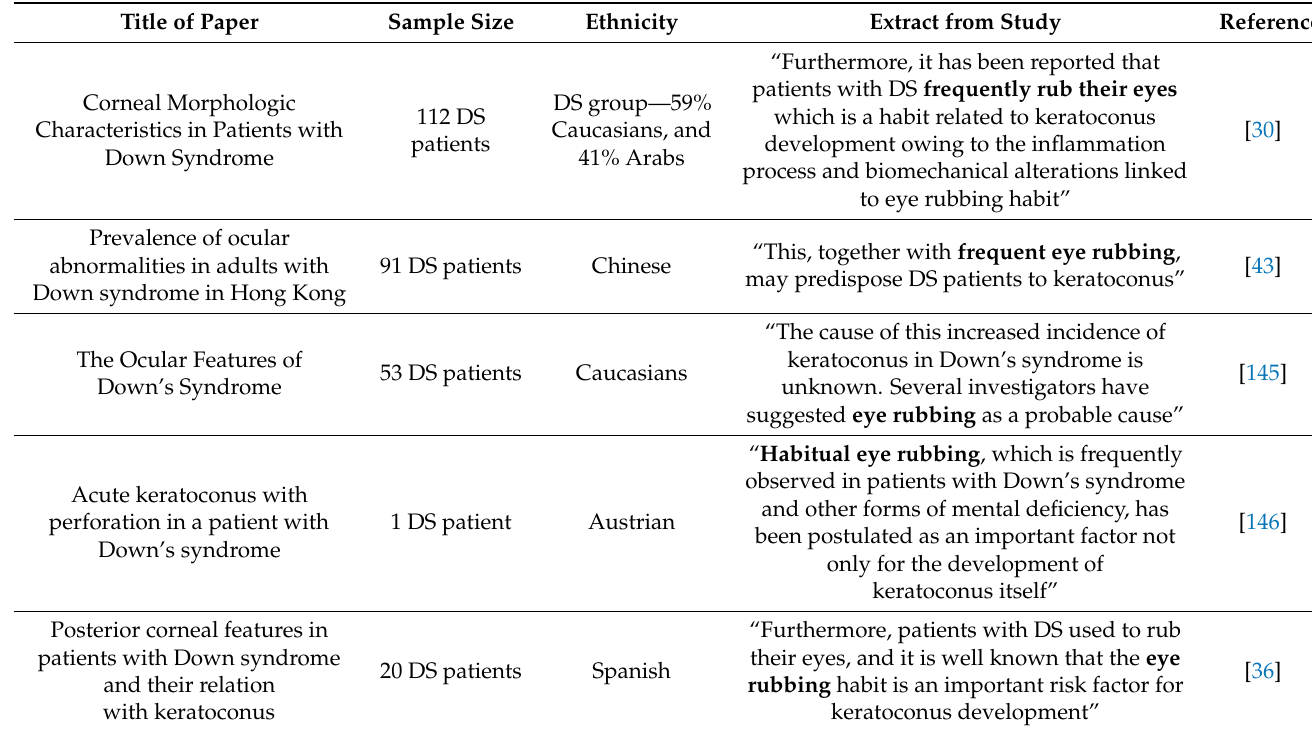
Table 2. Eye rubbing as a potential risk factor of KC in DS